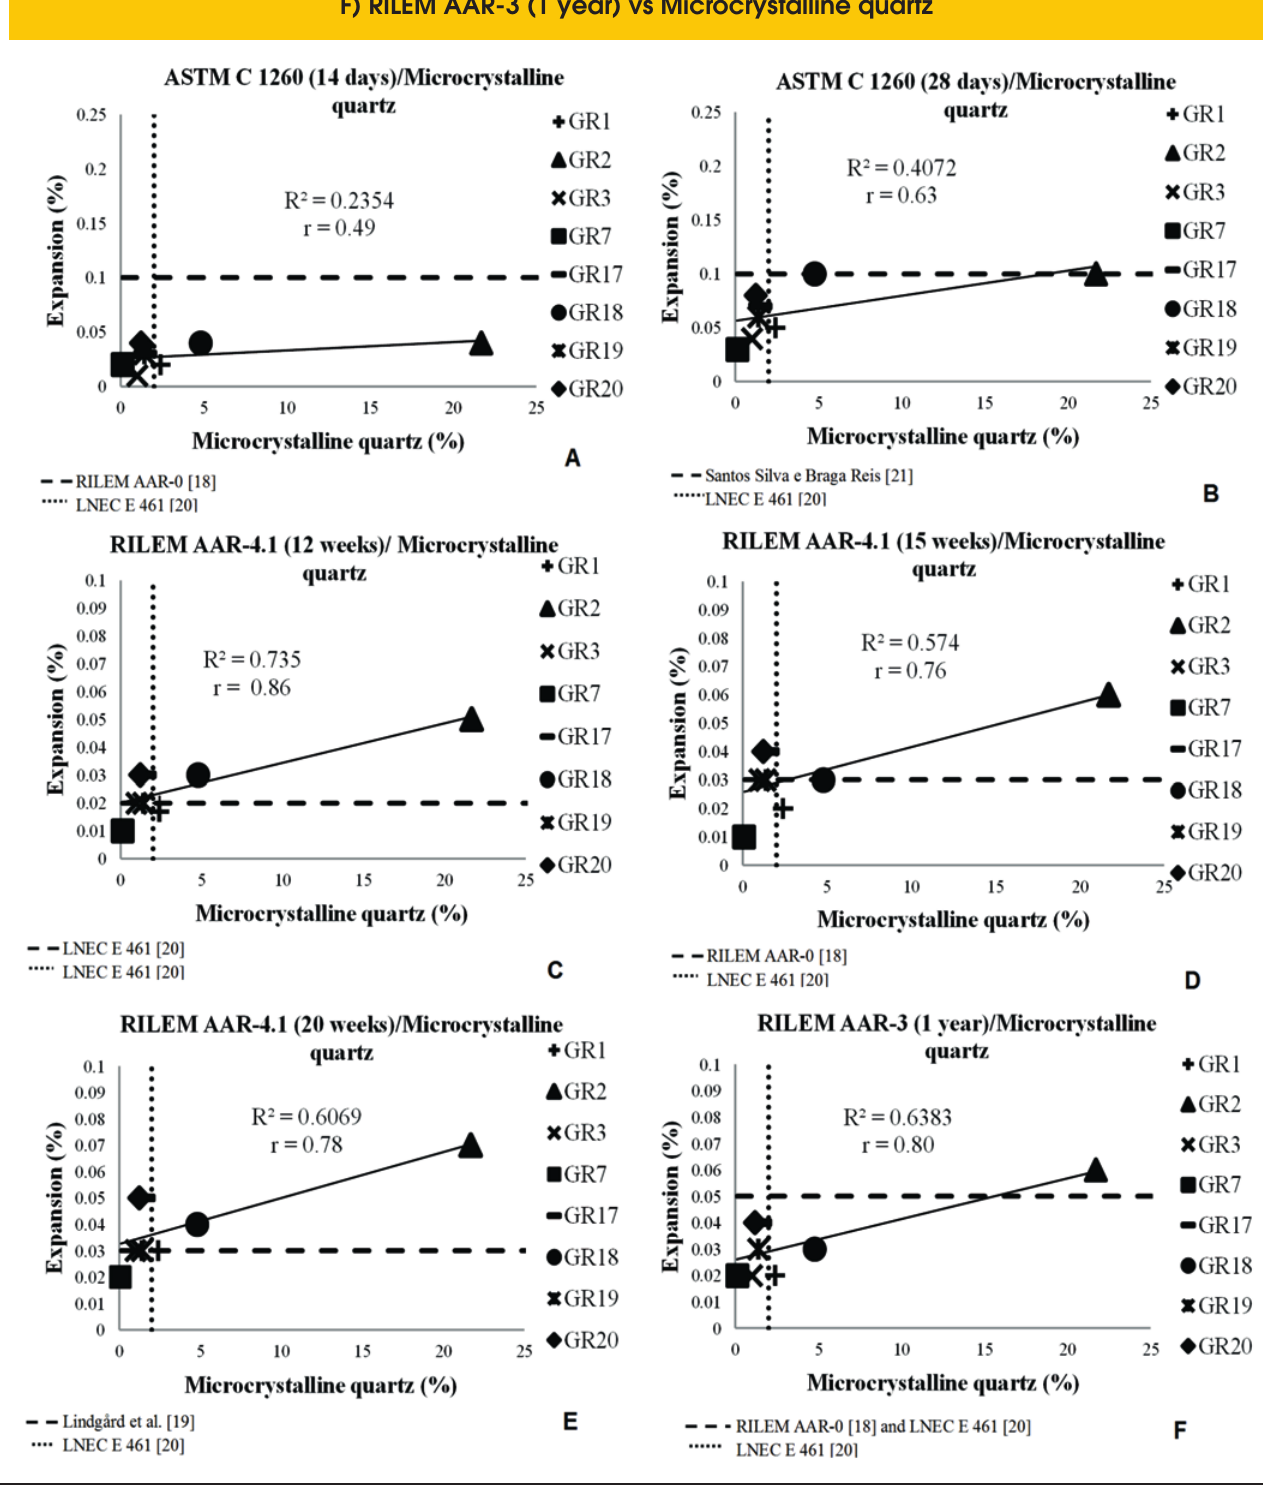
Figure 4 – Correlations between the expansion tests and the percentages of microcrystalline quartz. A) ASTM C 1260 (14 days) vs Microcrystalline quartz; B) ASTM C 1260 (28 days) vs Microcrystalline quartz; C) RILEM AAR-4.1 (12 weeks) vs Microcrystalline quartz; D) RILEM AAR-4.1 (15 weeks) vs Microcrystalline quartz; E) RILEM AAR-4.1 (20 weeks) vs Microcrystalline